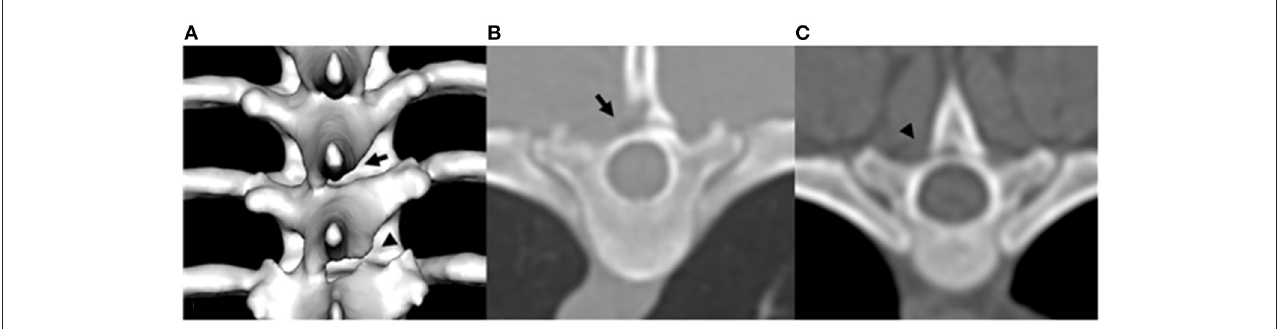
FIGURE1 Example of three-dimensional reconstructed CT image of T7 and T8 caudal articular process dysplasia in a Maltese (A) , transverse plane image of T6 caudal articular process aplasia in a Poodle (B) , and transverse plane image of T7 caudal articular process hypoplasia in a Shih tzu (C) . Arrowhead indicates caudal articular process hypoplasia. Arrow indicates caudal articular process aplasia.